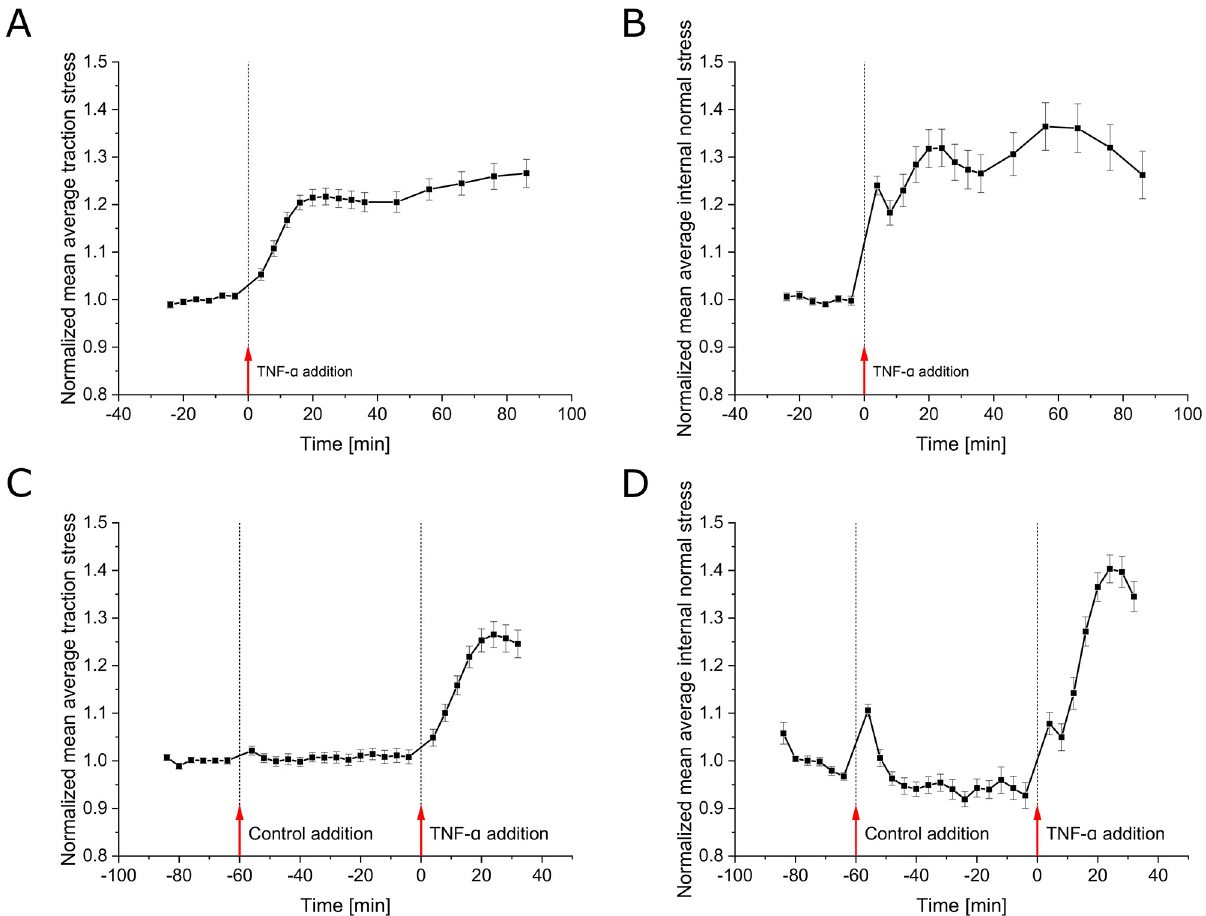
Fig 3. Time evolution of the mechanical response of HUVECs upon TNF- α exposure. A,B : Time course of the mean of spatially averaged (A) traction stress and (B) internal normal stress of multiple monolayer islands recorded at baseline and upon 20 ng/ml TNF- α treatment. Data is shown as mean ± SEM and has been normalized to the mean of the first 6 time points recorded prior to cytokine administration for each individual monolayer island ( n = 29, N = 3). Average stresses rise immediately upon TNF- α treatment ( p = 0.0021 for traction stress at 4 min vs. -4 min), reaching a peak after about 20 min. While substrate traction stress increases monotonically, for the internal normal stress a quick steep rise ( p < 0.001 at 4 min vs. -4 min) with a subsequent intermediate drop ( p = 0.027 from 4 to 8 min) can be observed. The peak after 20 min reaches slightly higher for internal normal stresses than for traction stresses (31.8% vs. 21.4% relative increase). C,D : Same as A,B, respectively, but for control experiment. After again recording a 20 min baseline, as control only the solvent (water) without TNF- α was applied. To the same samples TNF- α was added 1 h later at t = 0. Data is shown again as mean ± SEM and has been normalized to the mean of the first 6 time points for each individual monolayer island ( n = 27, N = 3). While the control addition had only a barely visible effect on the average traction stress, the average internal normal stress increased significantly after one time frame ( p < 0.0001 at -56 min vs. -64 min). This increase was followed by a quick decay reaching prior levels after three time frames. The later addition of TNF- α to the same samples caused, qualitatively, the same response as in the previous experiments without prior control administration while reaching slightly higher levels. Only the initial peak in the internal normal stress was smaller but was of about the same magnitude as in the case of the control